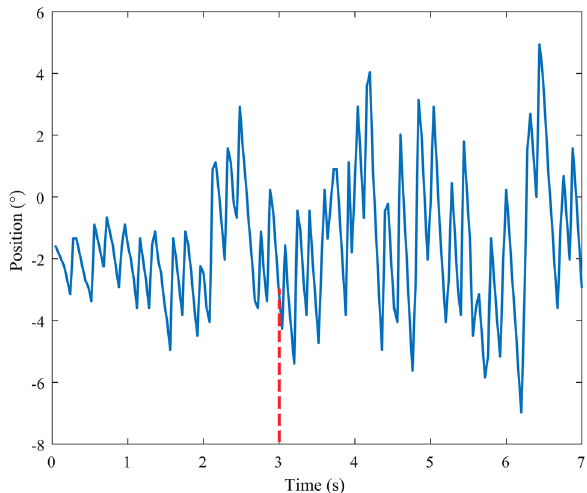
Figure 2. The horizontal nystagmus of a volunteer caused by constant rotational acceleration of 30°/s 2 during 0–7 s. The horizontal SPV of the volunteer tended to be approximately stable after 3 s.